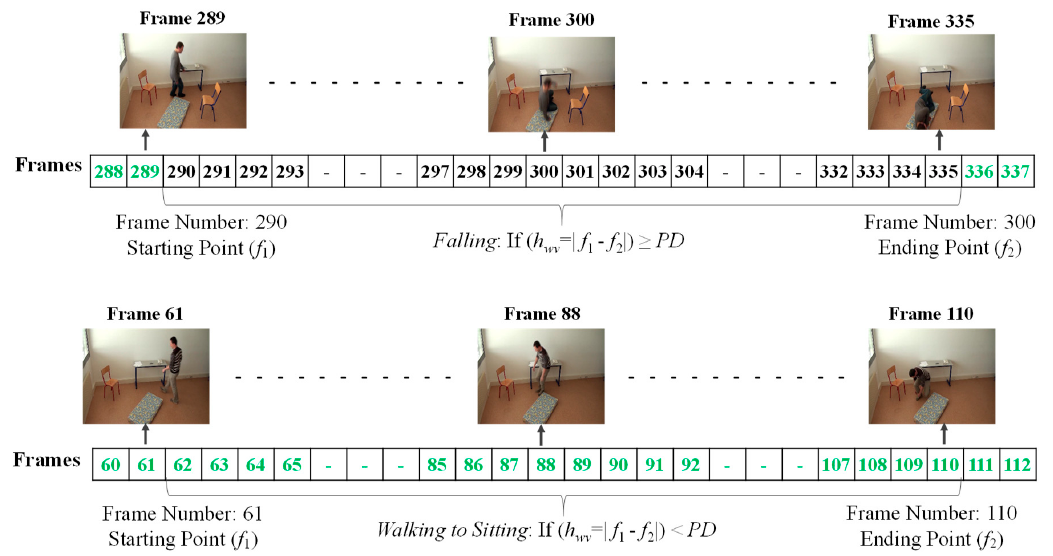
Figure 9. Observations in the period of abnormal and normal states. Upper part: falling; lower part: walking to sitting.